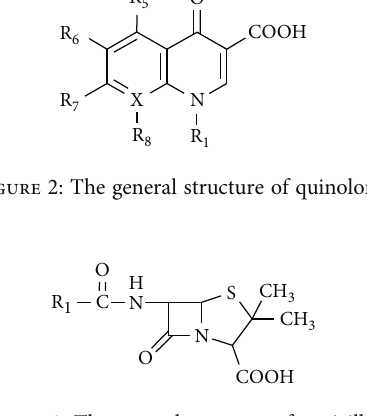
Figure 3: The general structure of